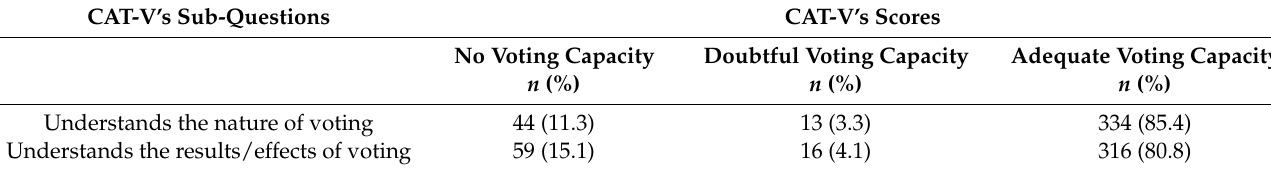
Table 2. Frequencies of the values ‘none’ ‘doubtful’, and ‘adequate voting’ of the CAT-V in the total